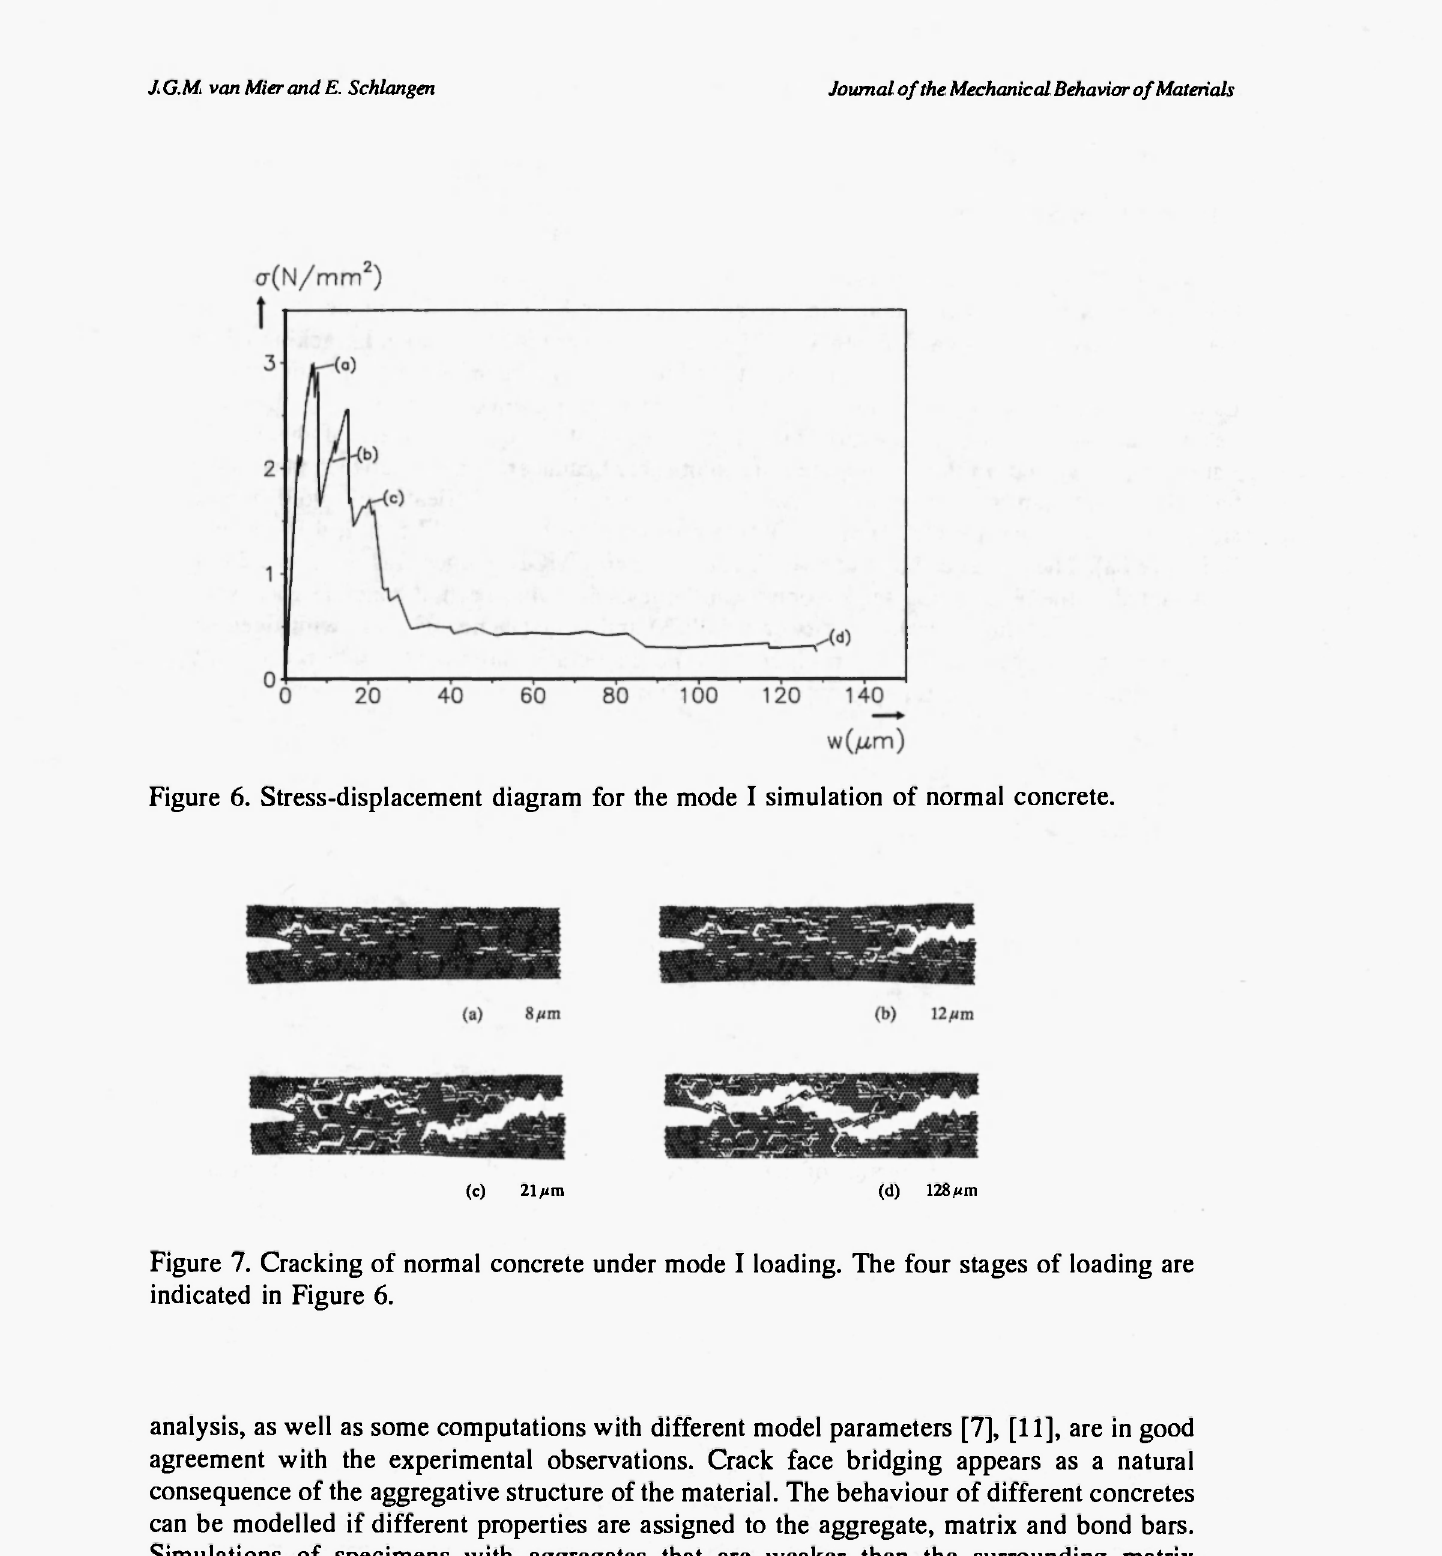
Figure 7. Cracking of normal concrete under mode I loading. The four stages of loading are indicated in Figure